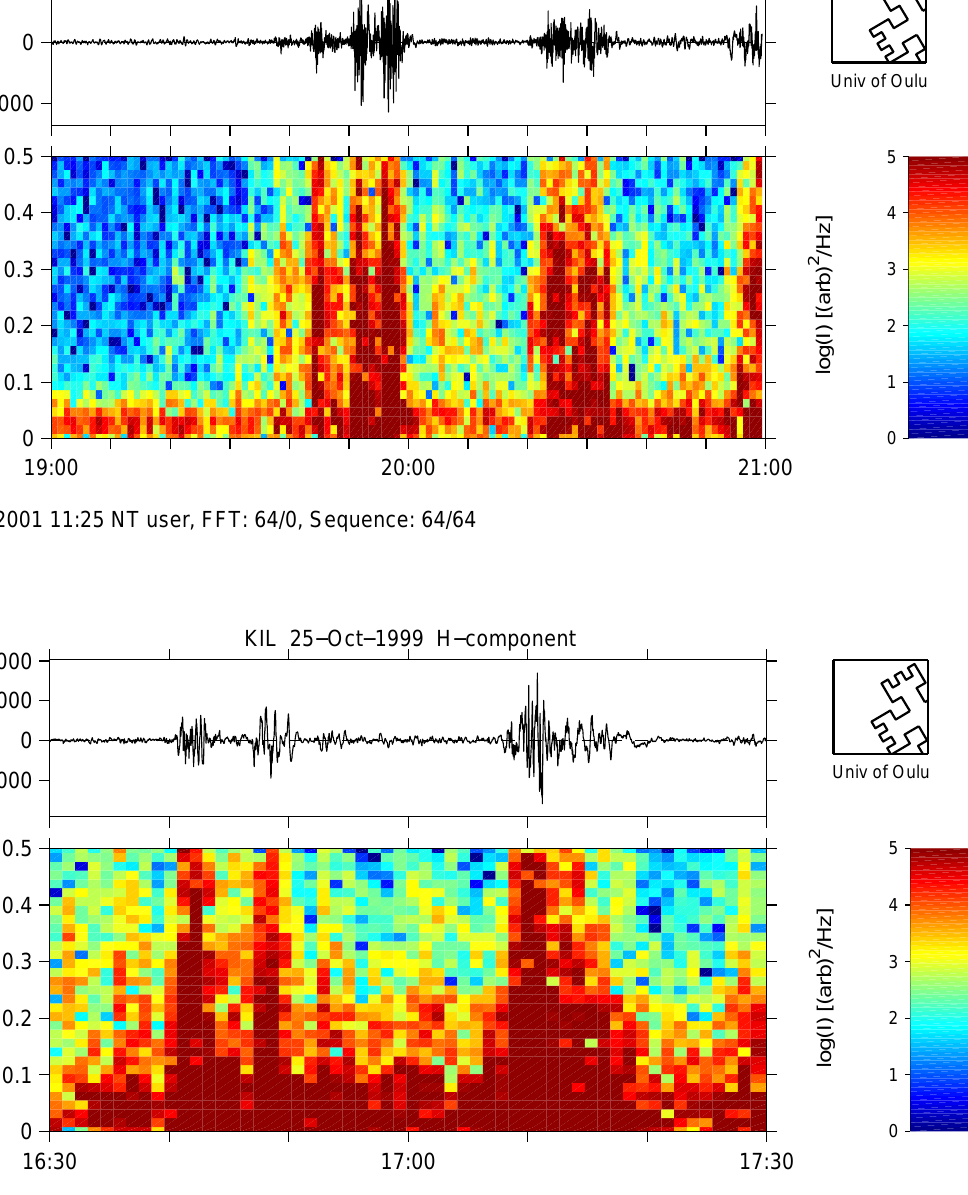
the different plasma content into